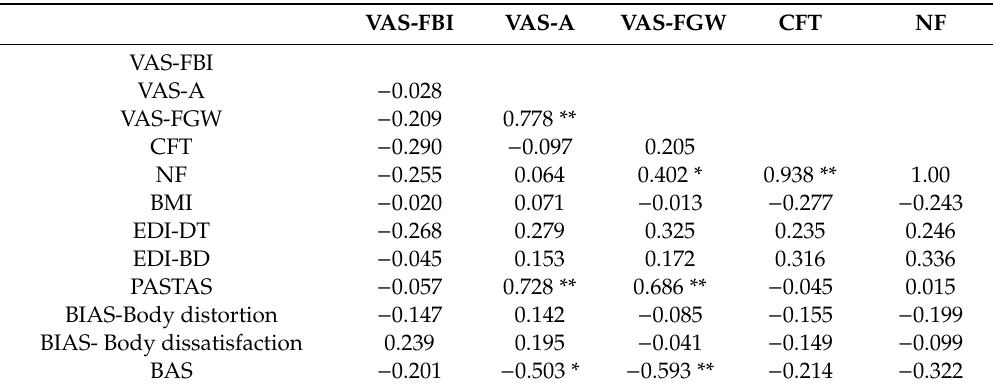
Table 4. Correlations between ED measures and VR body exposure responses in healthy participants with low BD.